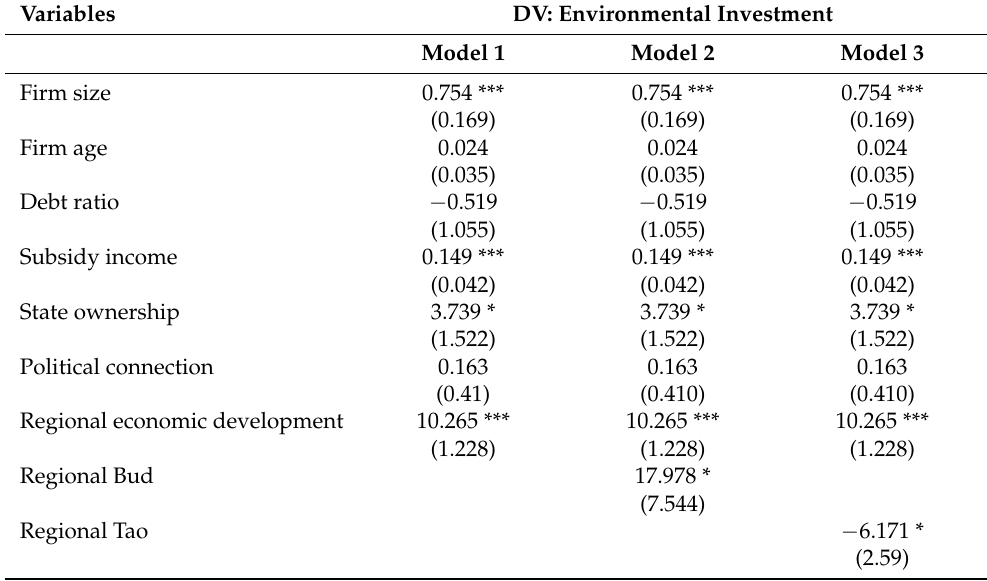
Table 3. Estimation of environmental